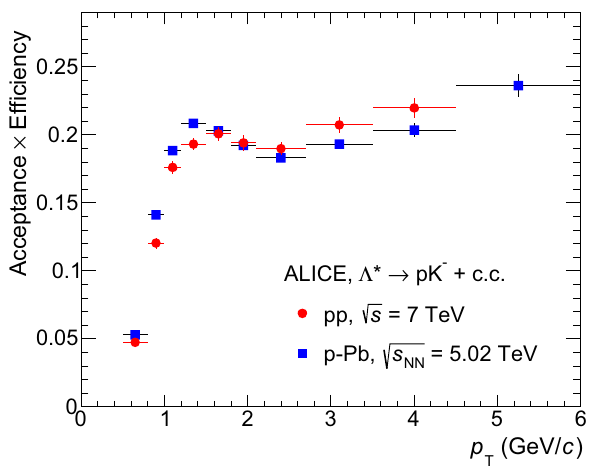
Fig. 2 Thegeometricalacceptancestimesreconstructionefficiency(A × ε ) for (cid:3) ∗ in minimum bias pp and p–Pb events. Uncertainties (bars) are statistical